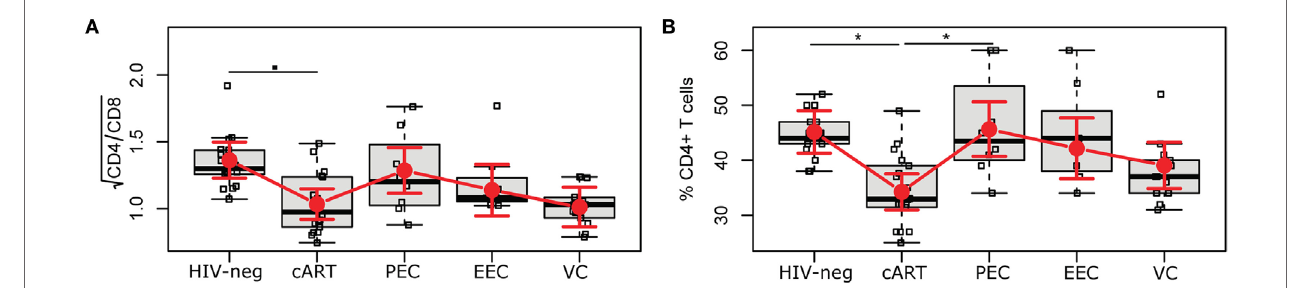
FigUre 2 | HIV controllers have a normal CD4/CD8 ratio and CD4%. The CD4/CD8 ratio (a) and the CD4% (B) were obtained using the MultiTest TruCount kit. The time point selected for this study is highlighted in Figure S1 in Supplementary Material. Boxplots represent the IQR and sample median (central solid black line). Red dots and vertical bars represent linear model estimated adjusted means and 95% confidence intervals (CI 95%). The CD4/CD8 ratio was square-root transformed; comparisons of means among groups were performed by contrasts/differences obtained after both bi- and multivariate-linear models fitted by ordinary least square regressions. P -values were corrected by the Tukey Honest Significant Difference post hoc method, and a type I error adjustment was conducted for multiple comparisons following the Holm-Bonferroni method. ▪ P < 0.1, * P < 0.05.